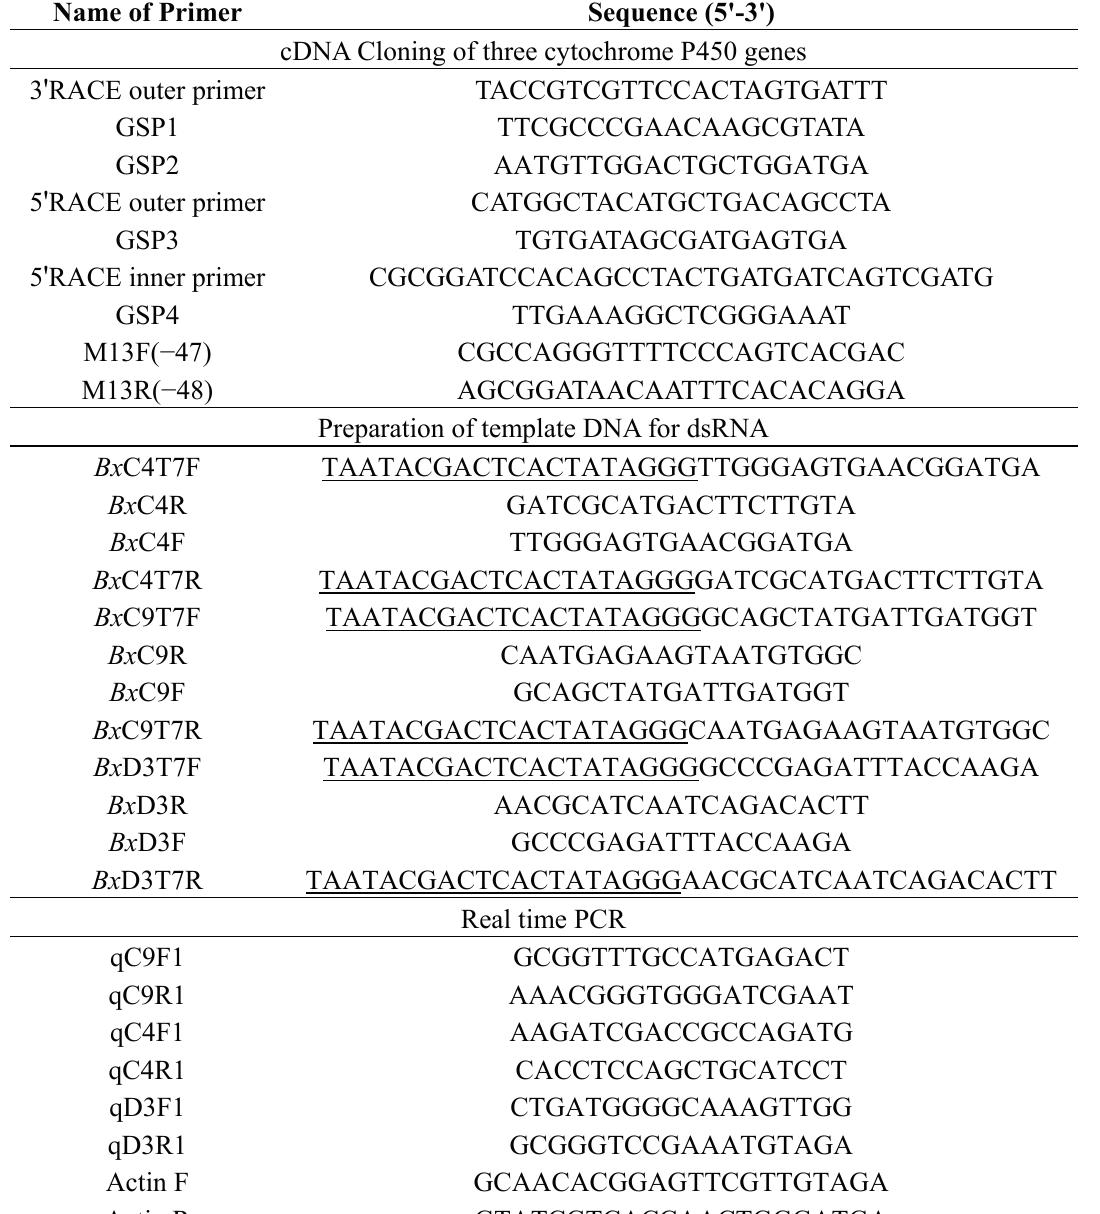
Table 2. PCR primers used in the present